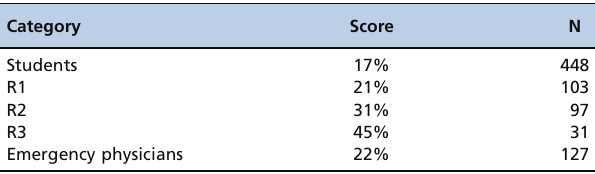
Table 1 - Scores for the students, internal medicine residents, and physicians in the study